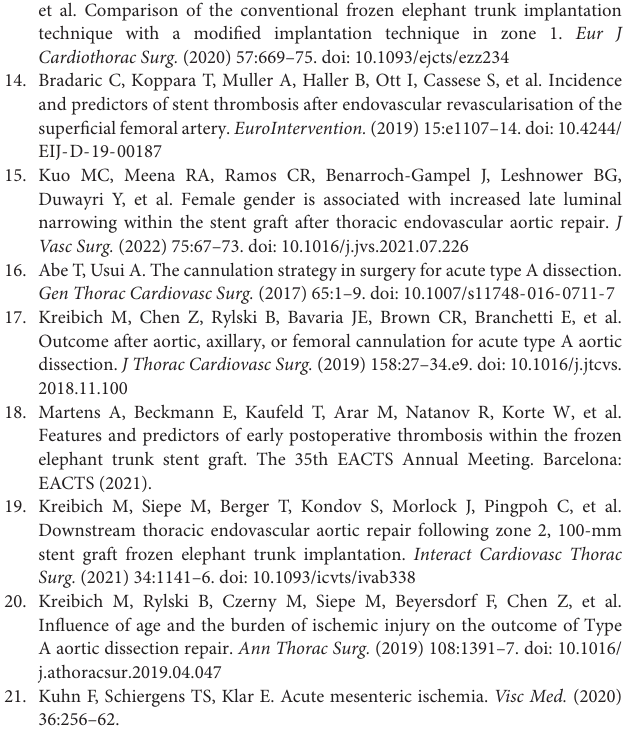
Supplementary Figure 1 | Computed tomography angiographic images of a previously undetected thrombus in the distal end of the stent-graft (A,C) axial plane, (B,D) sagittal